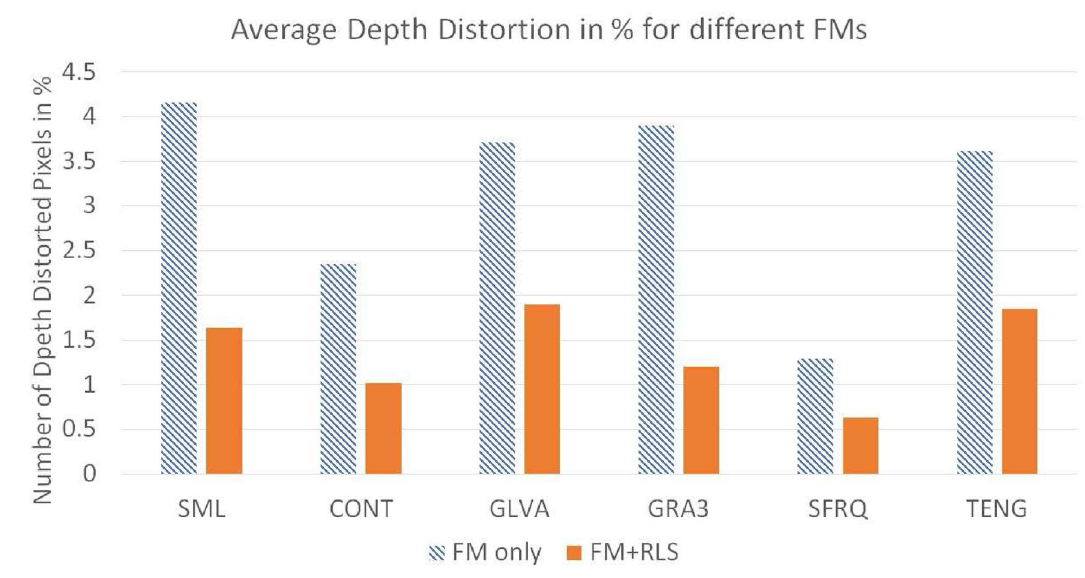
b ) 2 σ 2 2 a 2 σ 4 ( 2 ak ζ + ζ = +